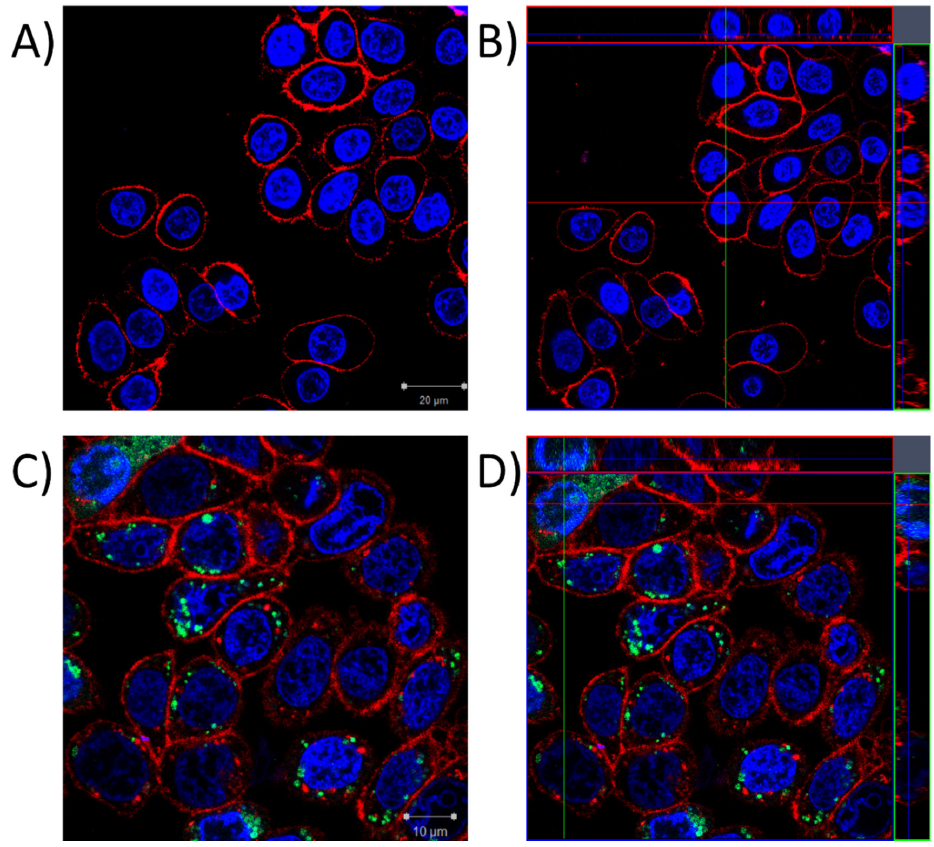
Figure 4. Confocal microscopy images of HT-29 cells, incubated with a solvent control ( A , B ) or 10 µM P8-D6 ( C , D ), with red staining for plasma membranes, blue for nuclear structures, and green as the auto-fluorescence of P8-D6. ( A ) and ( C ) show the central layer of the z-stacked structured illumination microscope (SIM) images, ( B ) and ( D ) shows a rendering of the images including the orthogonal cut view, where the nuclear residence of P8-D6 is visible in the top left corner of 4D.